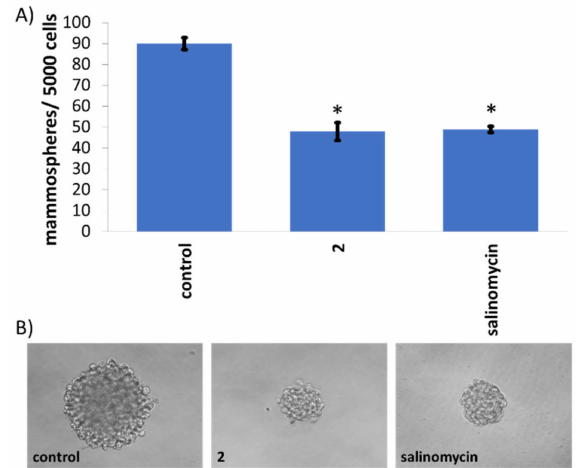
Figure 3. ( A ) Quantification of mammosphere formation with HMLER-shEcad cells untreated and treated with 2 and salinomycin at their respective IC 20 values for five days. Error bars = SD and Student’s t -test, * = p < 0.05. ( B ) Representative images ( × 20) of HMLER-shEcad mammospheres in